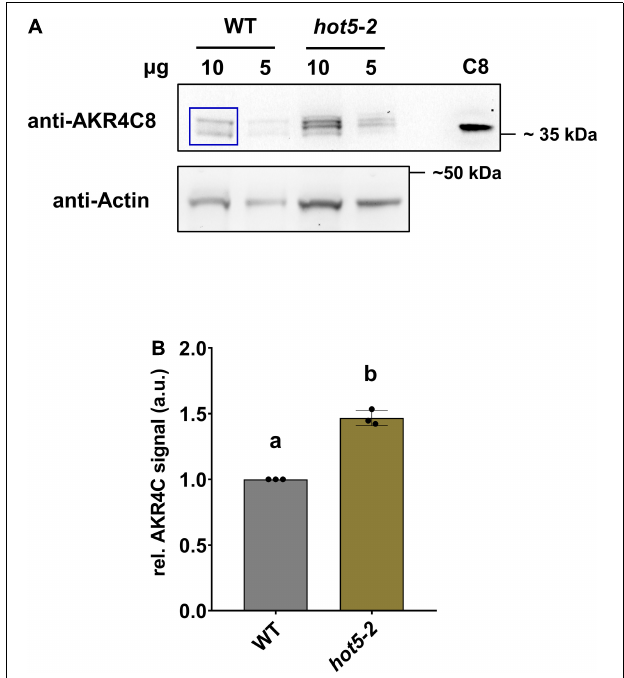
FIGURE 4 | Aldo-keto reductases (AKRs) are increased in hot5-2 . (A) Detection of AKR4C proteins in leaves. Shown is a representative immunoblot from three independent experiments. Total protein extracts (10 and 5 µ g) from leaf material were separated by SDS-PAGE. Immunoblots were probed with anti-AKR4C8 polyclonal antibodies (PHYTOAB, 1:5000 dilution) and anti-rabbit IgG HRP-conjugated (PHYTOAB, 1:10 000 dilution). Additionally, 10 ng of purified AKR4C8 protein was loaded (C8). Actin (Agrisera AS13 2640; first AB, 1:3000 dilution; second anti-rabbit-HRP, 1:10 000) was used as loading control. (B) Relative quantification of AKR4C. Relative AKR4C signal intensities from the 10 µ g samples were quantified using ImageJ (blue inset in A ). Values were normalized against actin and data represent the mean ± SD calculated from three independent experiments. Different letters indicate groups of T -test significant differences of p ≤